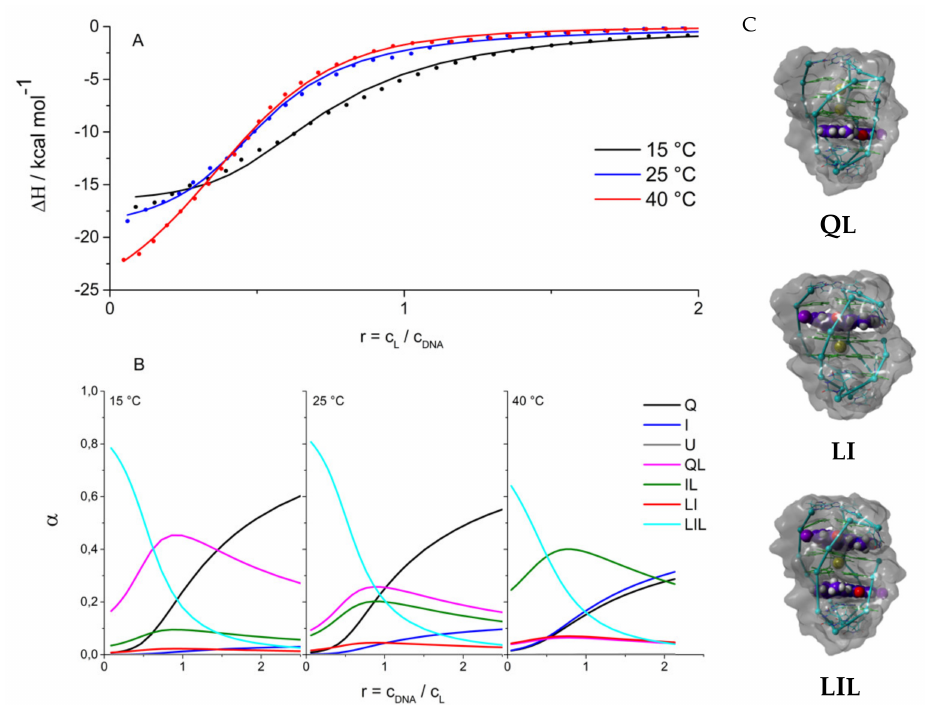
Figure 4. Ligand (306A) binding to 22GT: ( A ) ITC curves (dots) and global fits (lines) of the model function based on the mechanism presented in Figure 1. ( B ) Species present at different temperatures and ligand concentrations calculated using best fit values of the thermodynamic parameters (Table 2). ( C ) Structural models obtained by docking of the ligand to 22GT structures obtained by molecular dynamics simulations (Figure